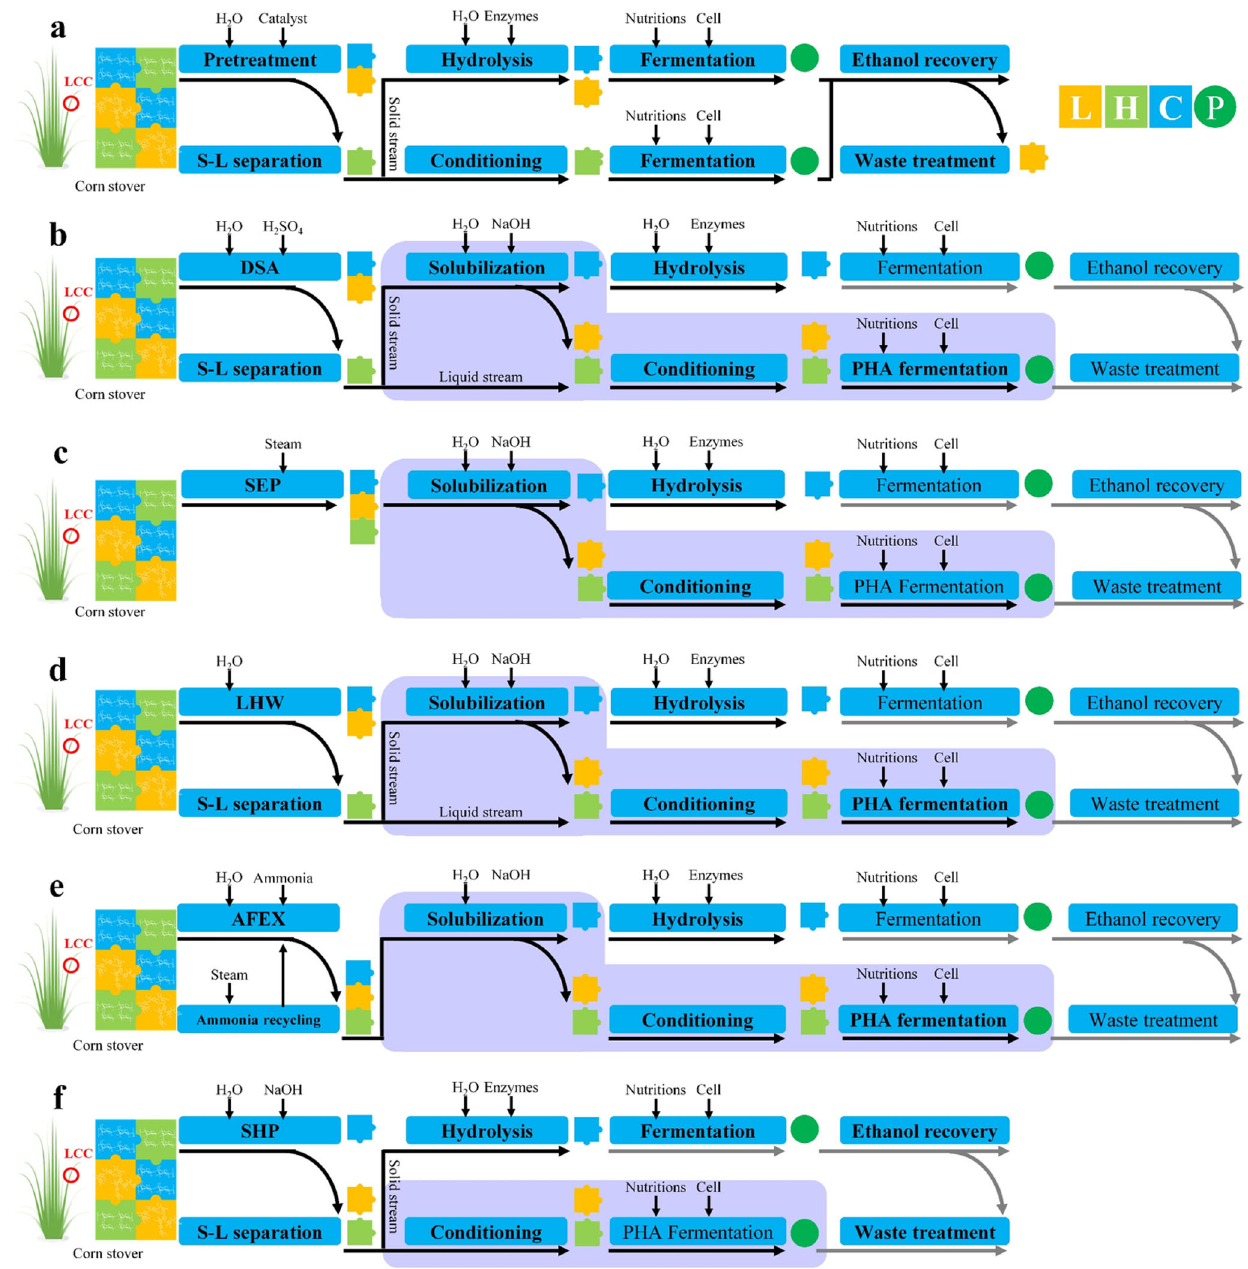
Fig. 1 The biore fi nery scenarios with the incorporation of ‘ plug-in processes of lignin (PIPOL) ’ . a A general biore fi nery process for bioethanol production; b PIPOL-integrated biore fi nery scenario with dilute sulfuric acid pretreatment (DSA); c PIPOL-integrated biore fi nery scenario with steam explosion pretreatment (SEP); d PIPOL-integrated biore fi nery scenario with liquid hot water pretreatment (LHW); e PIPOL-integrated biore fi nery scenario with ammonia fi ber expansion (AFEX); f PIPOL-integrated biore fi nery scenario with sodium hydroxide pretreatment (SHP). Purple module represents PIPOL by integrating the dissolution, conditioning, and bioconversion of lignin. L in orange square represents lignin, H in light green square represents hemicellulose, C in blue square represents cellulose, P in green circle represents product, S – L separation represents solid – liquid separation, LCC represents lignin – carbohydrate